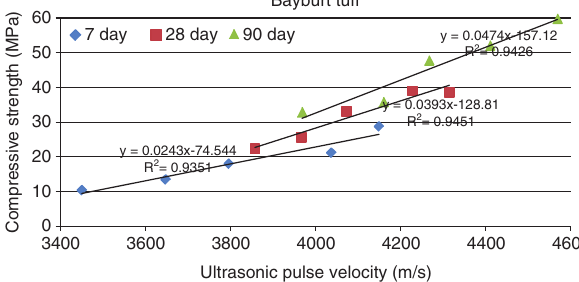
Figure 8 Relationship between ultrasonic pulse velocity and com- pressive strength of samples for Bayburt